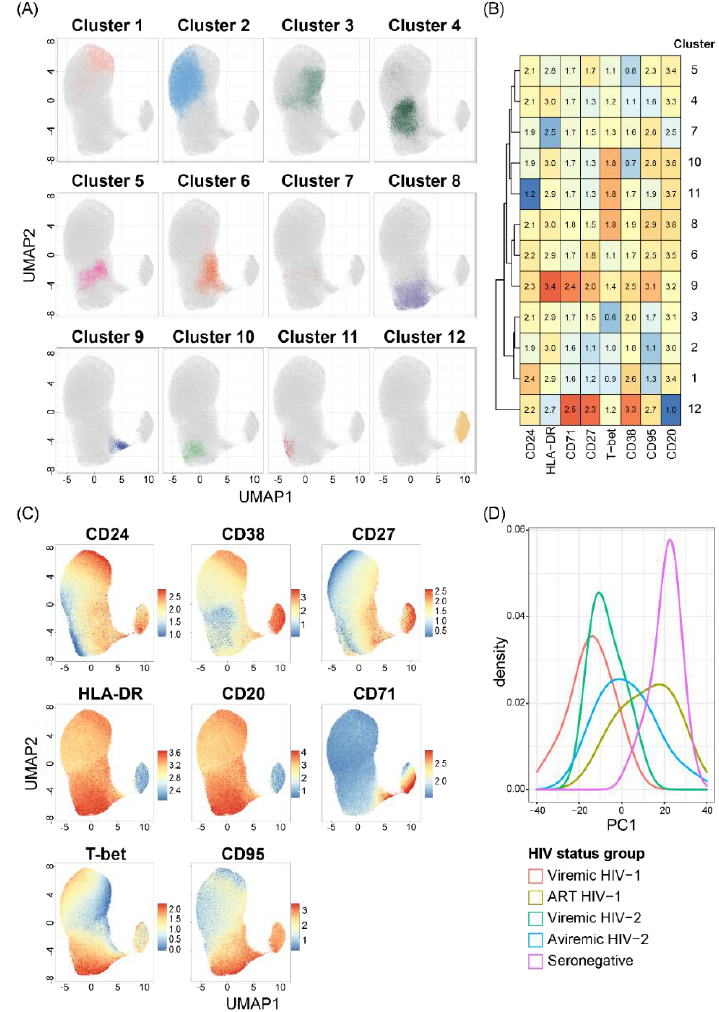
Figure 2. FlowSOM analysis showed alterations in B-cell phenotypes among HIV-1- and HIV-2- infected individuals. B-cells from all study participants were clustered according to CD24, CD38, CD27, HLA-DR, CD20, CD71, T-bet and CD95 expression using the FlowSOM algorithm. ( A ) Flow- SOM clusters projected on a UMAP plot, generated using an equal number of cells from each HIV status group, based on the expression of the above mentioned eight markers. ( B ) Heatmap displaying scaled marker expression values within each FlowSOM cluster, and the color coding is based on marker expression centered and scaled by column ( C ) Expression of the eight markers is visualized on individual UMAP plots. ( D ) A principal component analysis (PCA) was performed on FlowSOM cluster frequency. The density plot display PC1 values, for treatment-naïve or sub-optimally ART- treated HIV-1 (viremic HIV-1, n = 8), successfully ART-treated HIV-1 (ART HIV-1, n = 7), viremic HIV-2 (viremic HIV-2, n = 8), treatment-naïve aviremic HIV-2 (aviremic HIV-2, n = 12)-infected individuals and HIV seronegative (seronegative, n = 25)